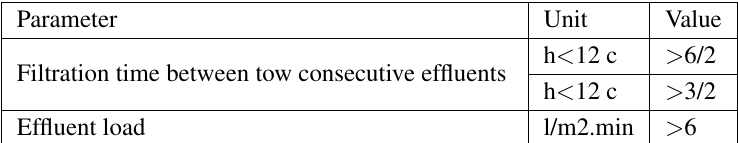
Table 1. Germany Code for wastewater treatment by constructed